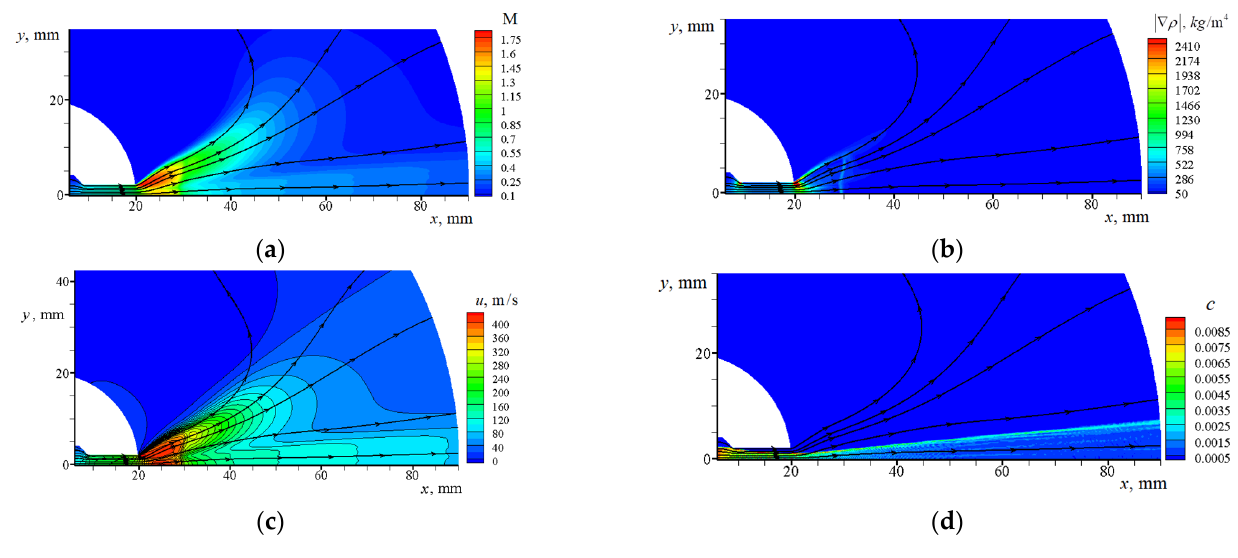
Figure 13. Calculated data for a two-phase gas–particle jet exhausting from a channel into a slotted space with h = 0.2 mm: ( a )—Mach-number isolines M ( x , y ) and gas-flow streamlines; ( b )—isolines of density gradient |∇ ρ | ; ( c )—longitudinal gas velocity u ( x , y ) and gas-flow streamlines; ( d )—concentration of particles c ( x , y )